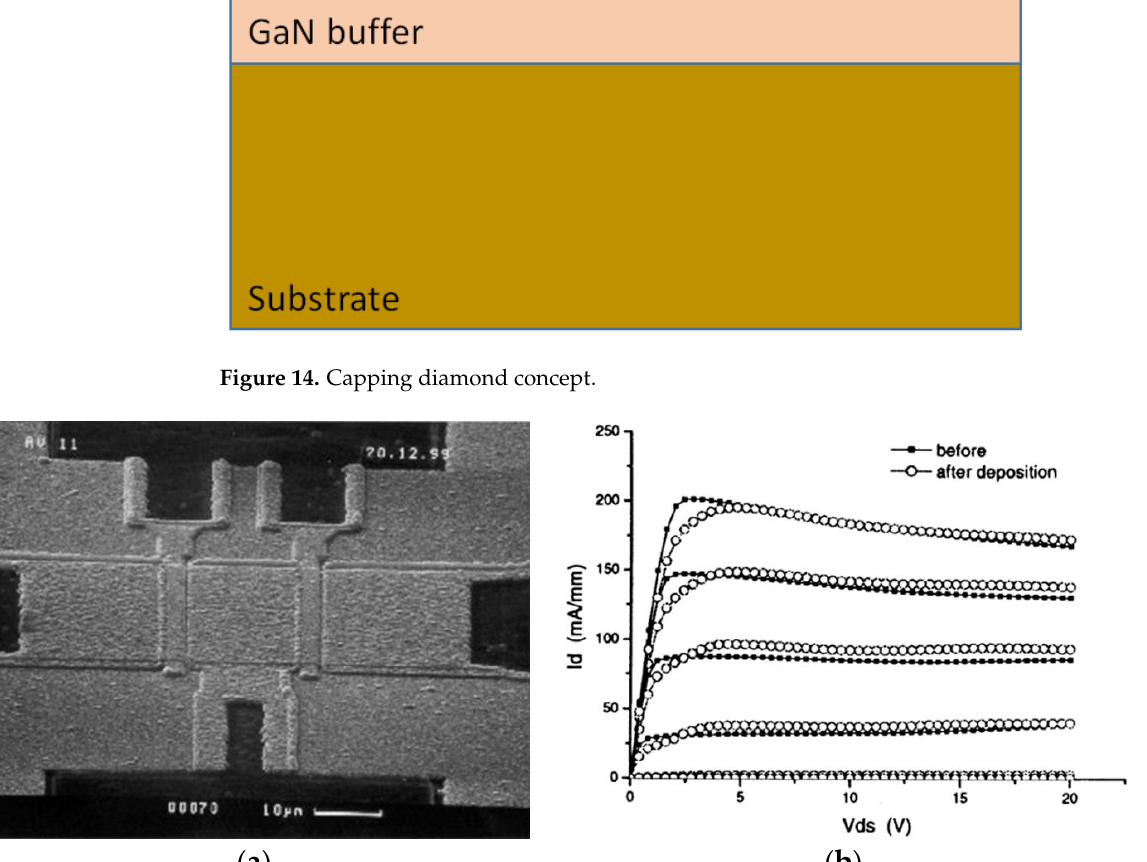
finger GaN FET coated with a 0.7 µm-thick PCD film (reprinted from Diam. Relat. Mat., vol. 10, no.